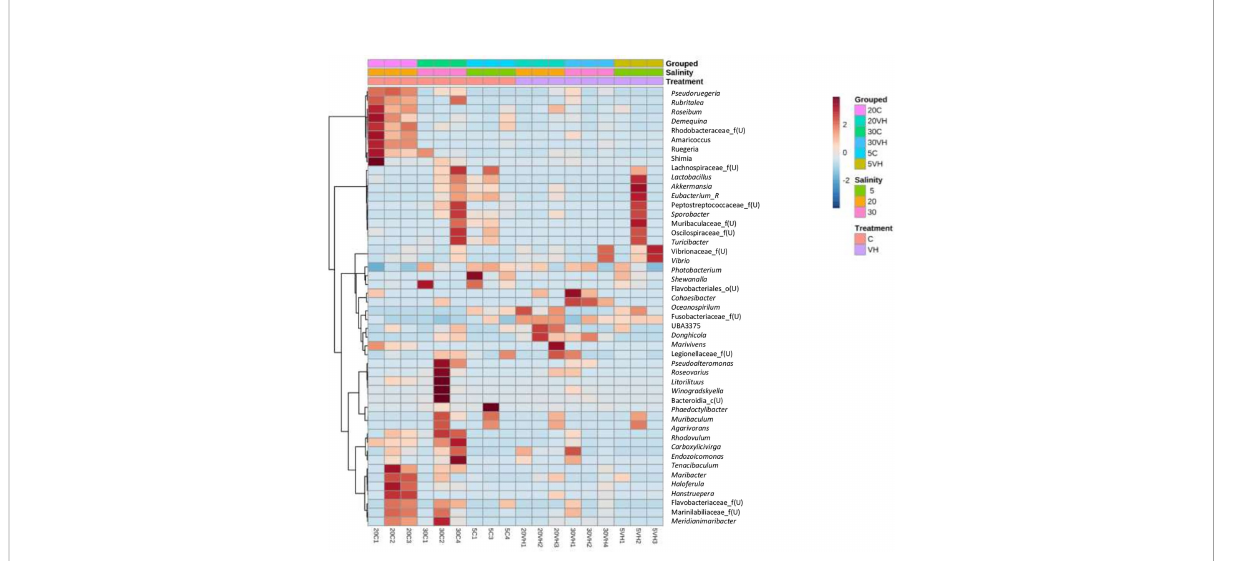
FIGURE 7 The heatmap analysis of top 50 genera on gut microbiota of Litopenaues vannamei cultured at different salinity levels and exposed to Vibrio harveyi . The red colour show the higher abundance of the genera, and the blue colour is the lower abundance (VH, Vibrio harveyi infected group and C, Control group; 5, 5 ppt, 20, 20 ppt and 30, 30